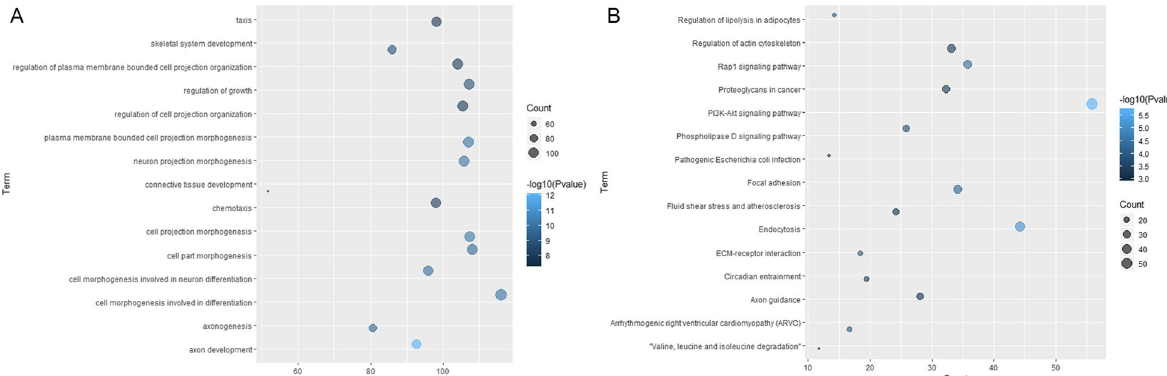
Fig. 2 Significantly enriched GO terms and KEGG pathways of DEmRNAs between OA and normal controls. A BP, biological process; B KEGG